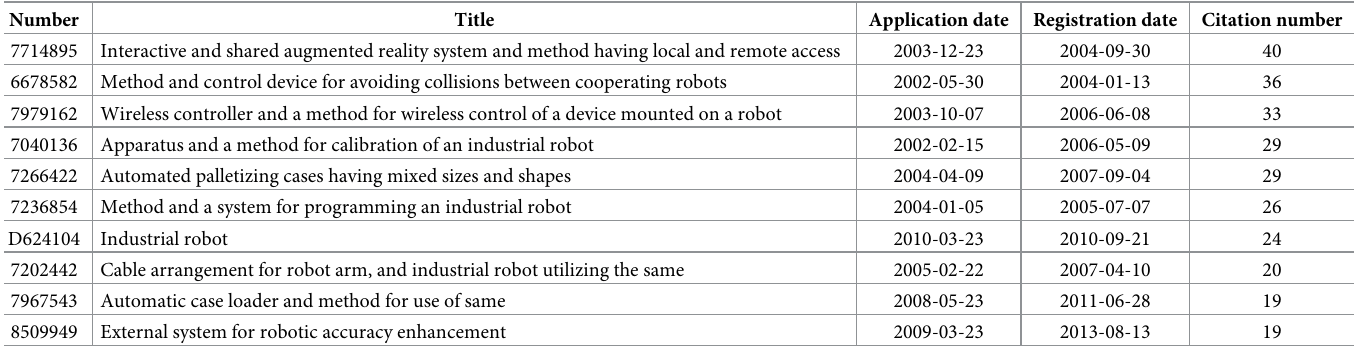
Table 2. Top ten patents related to industrial robot